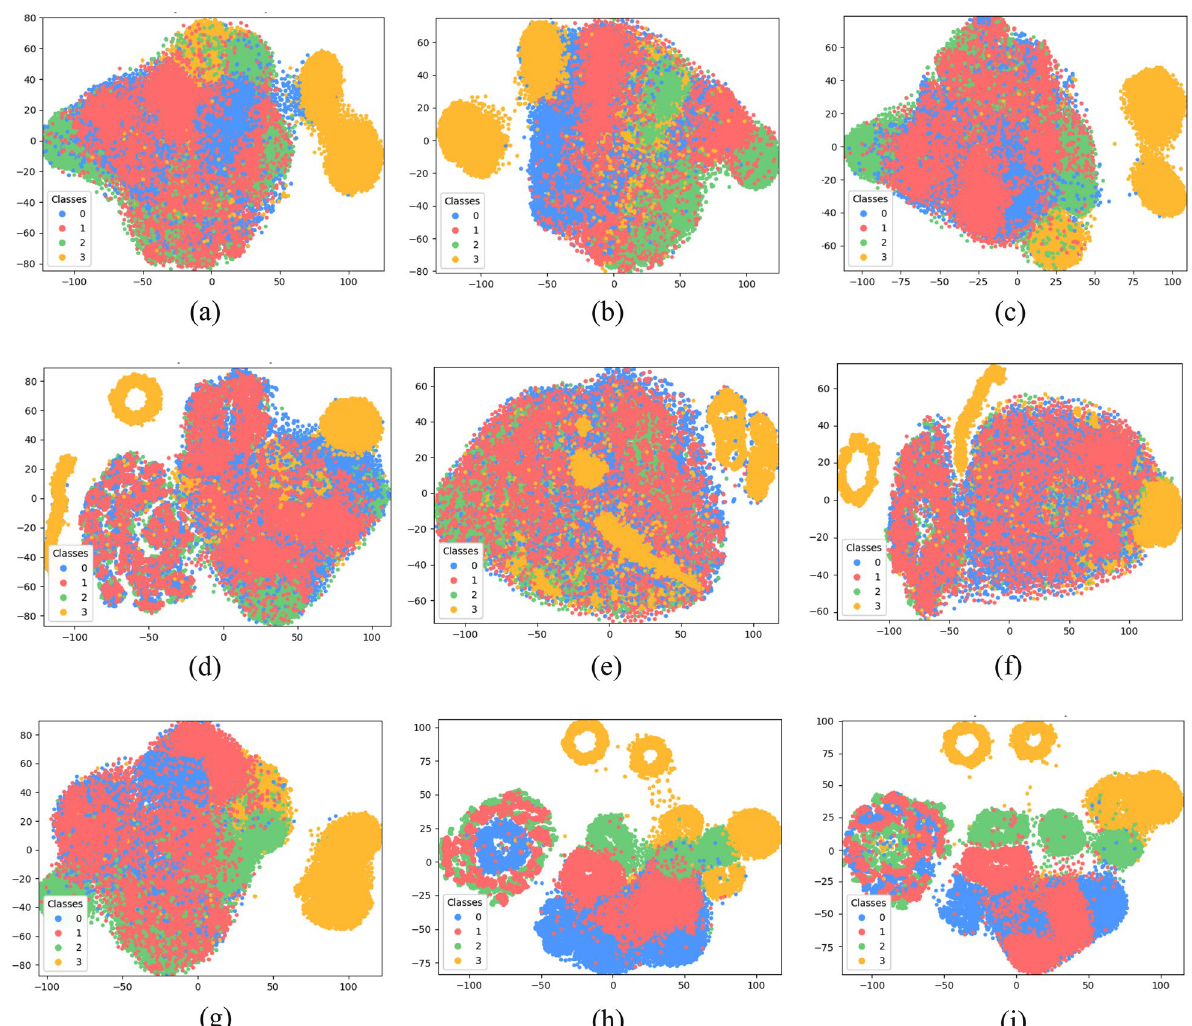
Figure 14 Visualization of features using t-SNE: a CNN; b WCNN; c MKCNN; d WaveletNet-L; e WaveletNet-m; f WaveletNet-M; g RSN; h SincNet; i DFAWNet